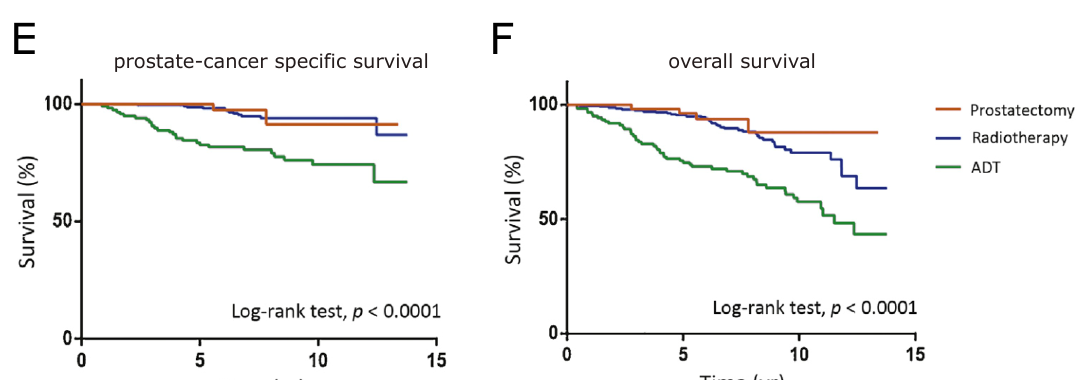
Figure 7. Effects of long-term androgen deprivation in human LNCaP cells and in a clinical study. Gene set enrichment analysis of genes after 5 months of androgen deprivation as compared to control cells (GSE8702, [27]). ( A ) Genes associated with TNF α -mediated NF- κ B signaling are significantly enriched by androgen deprivation. ( B ) Normalized enrichments scores (NES) of hallmark gene sets significantly enriched in androgen-deprived cells, including several inflammation-response